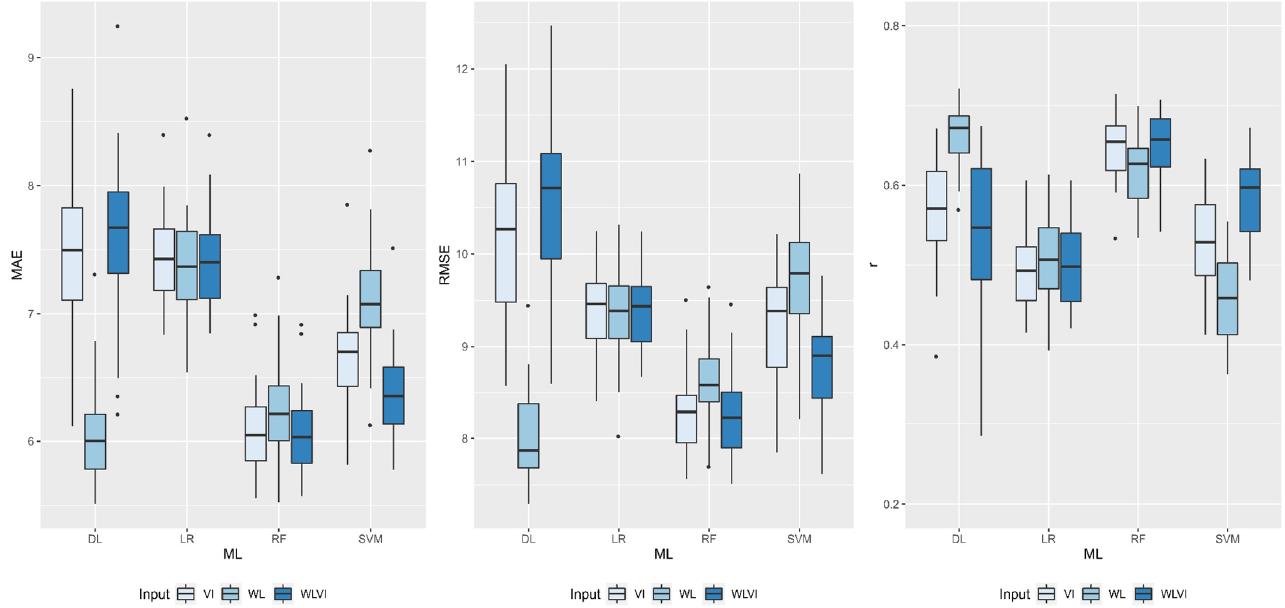
Figure 5. Boxplot for mean absolute error (MAE), root mean squared error (RMSE), and Pearson’s correlation coefficient (r) between estimated and observed values for grain yield in soybean obtained with different machine learning models (DL, RF, SVM, and LR) and input configurations. DL: deep learning (DL); RF: random forests; SVM: support vector machine; LR: linear regression; WL: spectral bands wavelengths; VI: spectral vegetation indices; WLVI: a combination between spectral bands and vegetation indices.